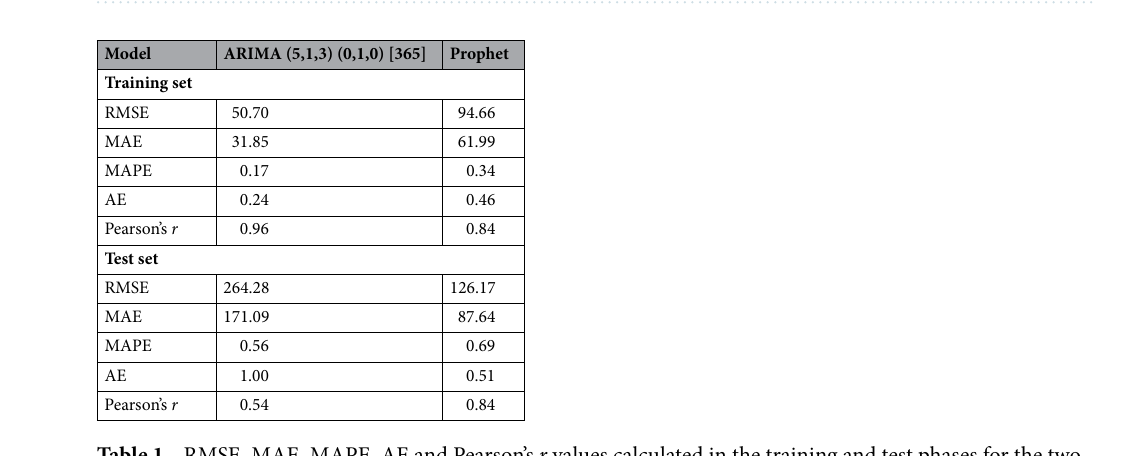
Figure 2. The decomposition using moving averages ( A ), and the boxplot of the daily reported incidence of HFMD for the same days of the week in four seasons in Hubei Province, China by R4.0.3 software (https :// www.R-proje ct.org) ( B ).